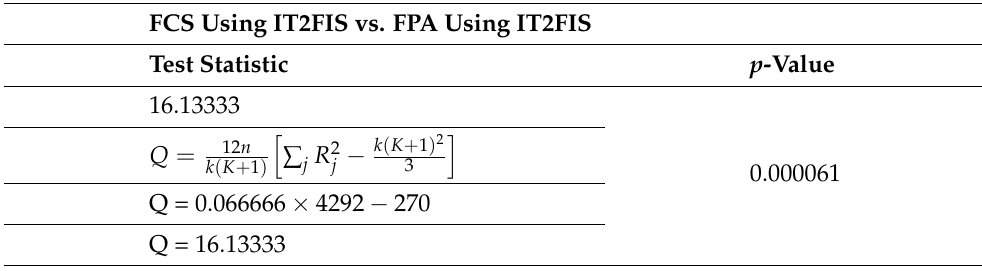
Table 11. Friedman test in comparing FCS Using ST2FIS vs. FPA Using ST2FIS.